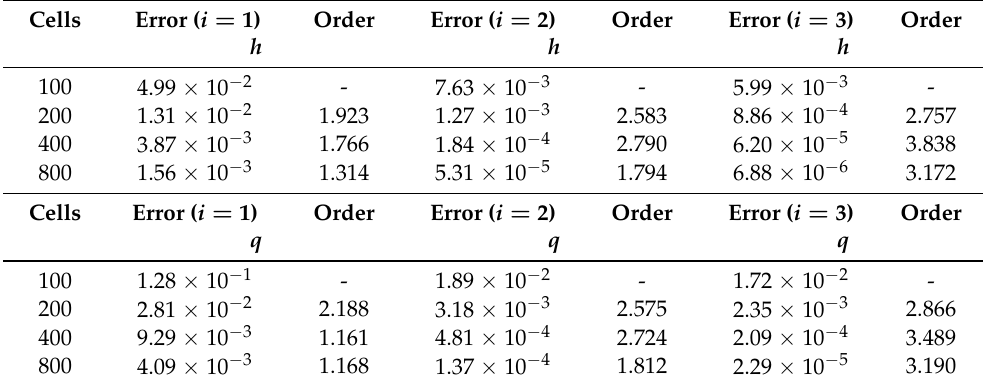
Table 9. Test 3.1. Differences in L 1 -norm with respect to the stationary solution and convergence rates for NWBM i , i = 1,2,3.